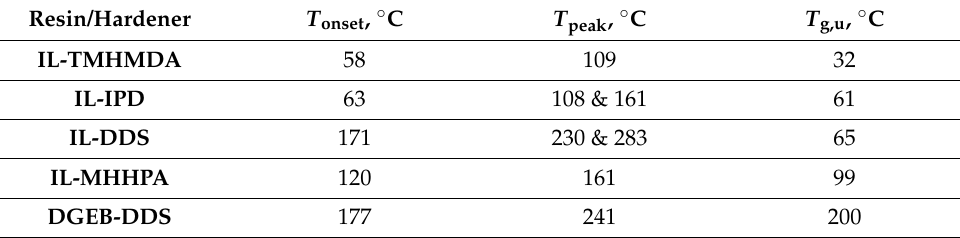
Figure 2. DSC thermograms of the uncured resin ‐ hardener mixtures, including the first (top) and second (bottom) heating. Curves shifted vertically for better visibility. Table 3. Characteristic temperatures obtained from DSC measurements performed on the uncured systems: T onset and T peak of the curing reaction (first heating), and glass transition temperature ( T g,u ) (second heating).